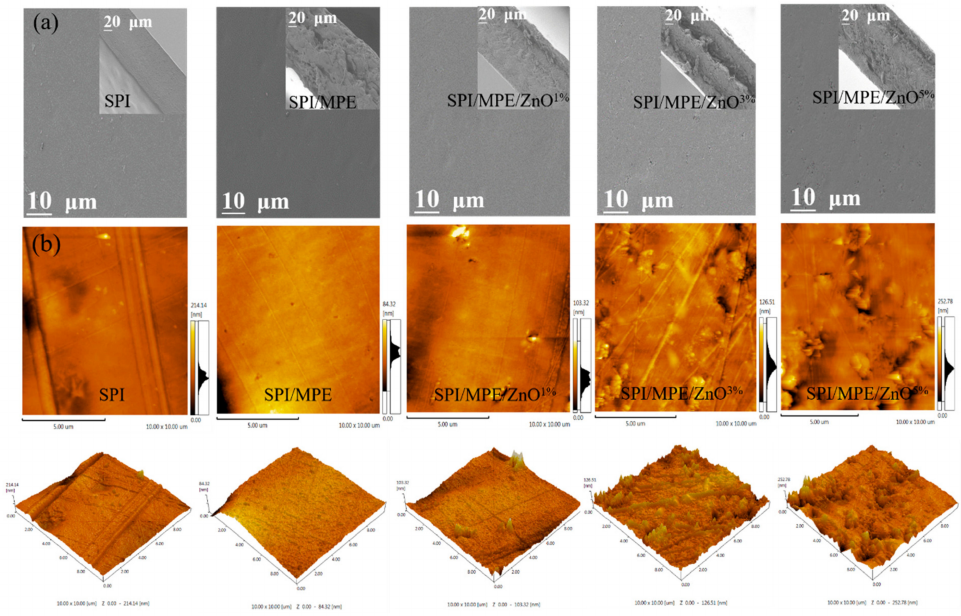
Figure 4. The SEM micrographs of surface and cross-section for SPI films ( a ). 2D and 3D images of surface topography for SPI films ( b